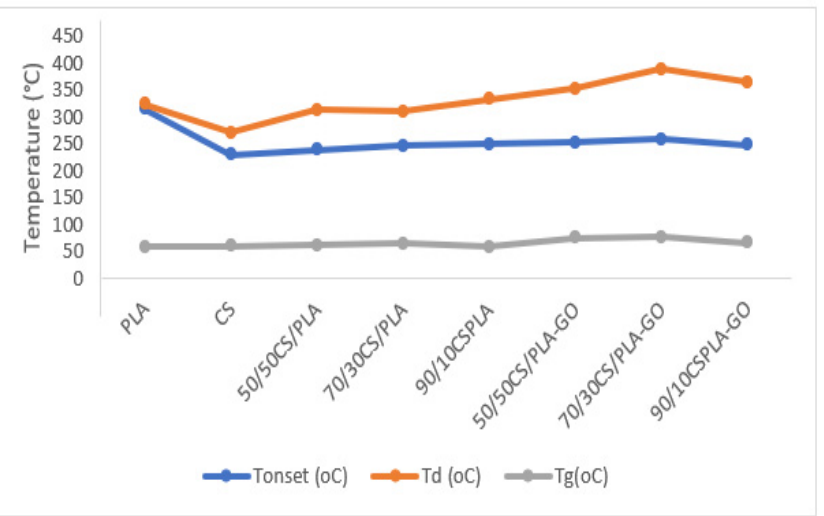
Figure 7. Thermal stability analysis of CS, PLA and CS/PLA with and without GO composites.